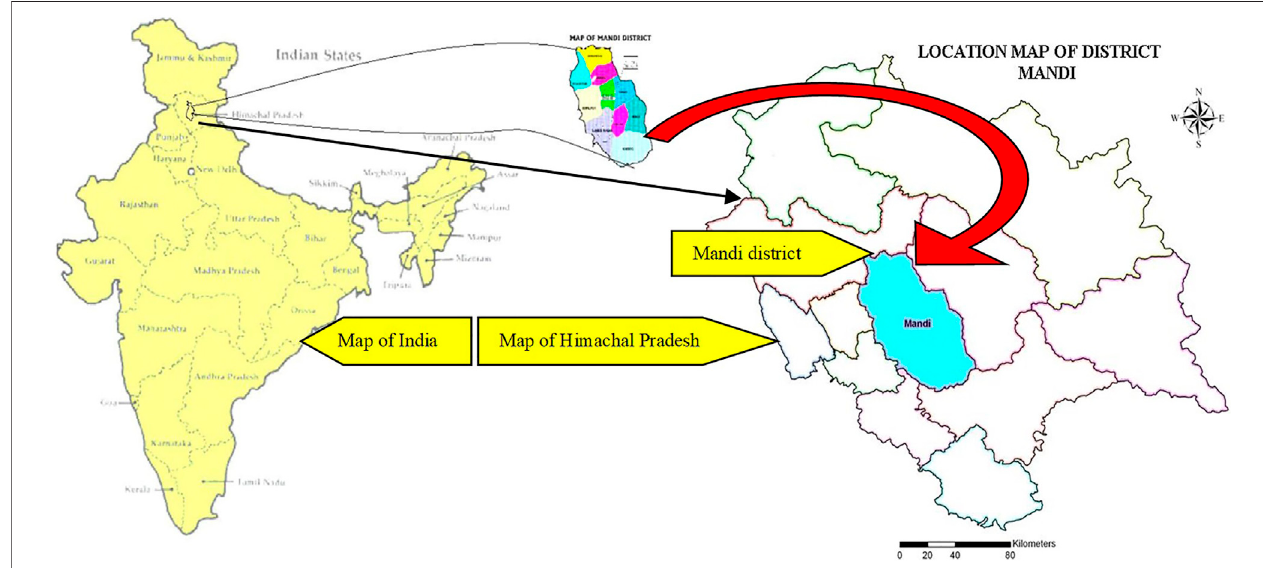
FIGURE 1 | Maps of India and the Himachal Pradesh province showing the location of Mandi district, Himachal Pradesh, and India (study area).